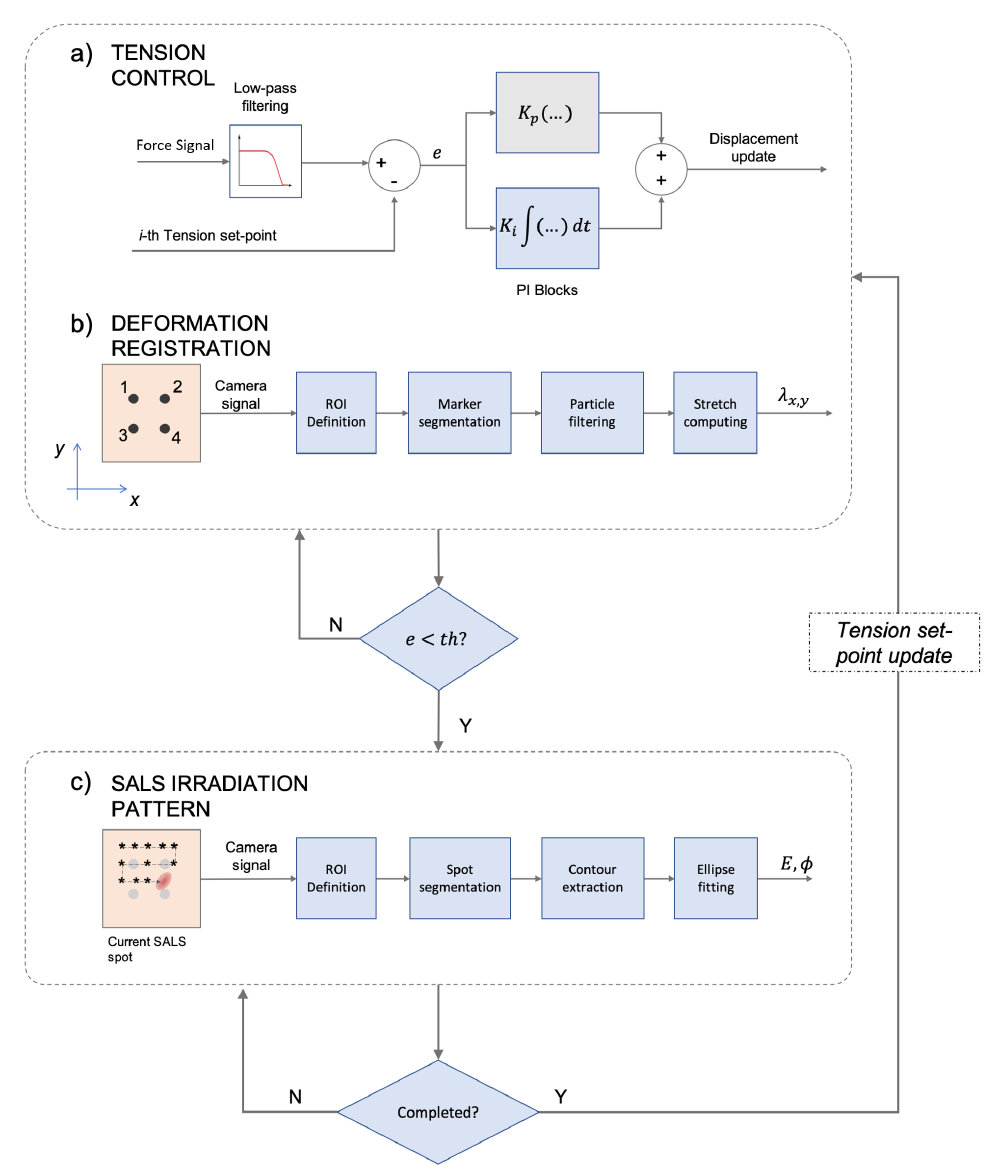
Figure 5. Schematic of the software workflow with particulars concerning the tension control ( a ), the deformation registration ( b ) and the SALS irradiation pattern ( c )